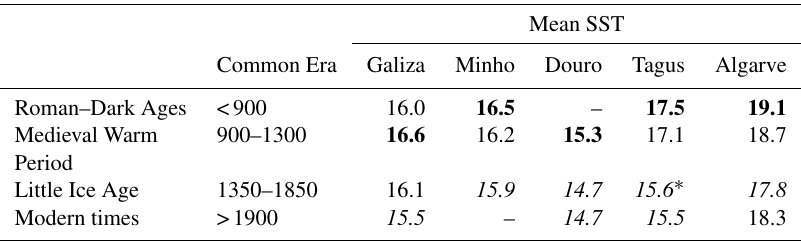
SST at the Iberian Margin during the major climatic periods of the last 2000 years. The italic and bold font highlight, Table 2. Mean U k (cid:48) 37 respectively, colder and warmer